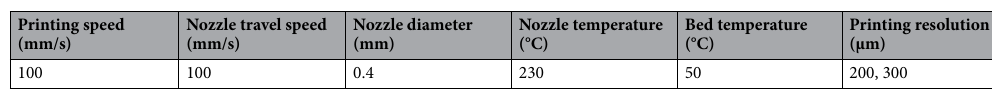
Table 1. Printing conditions for PLA channel